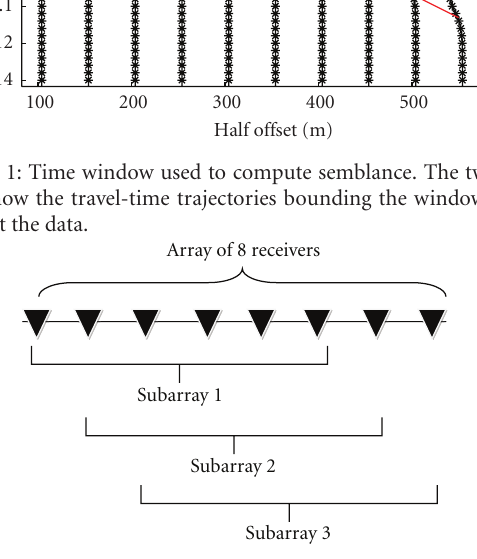
Figure 2: Concept of spatial smoothing.